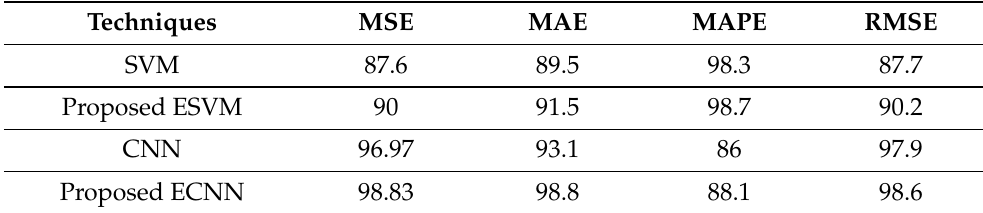
Table 3. Accuracy rates